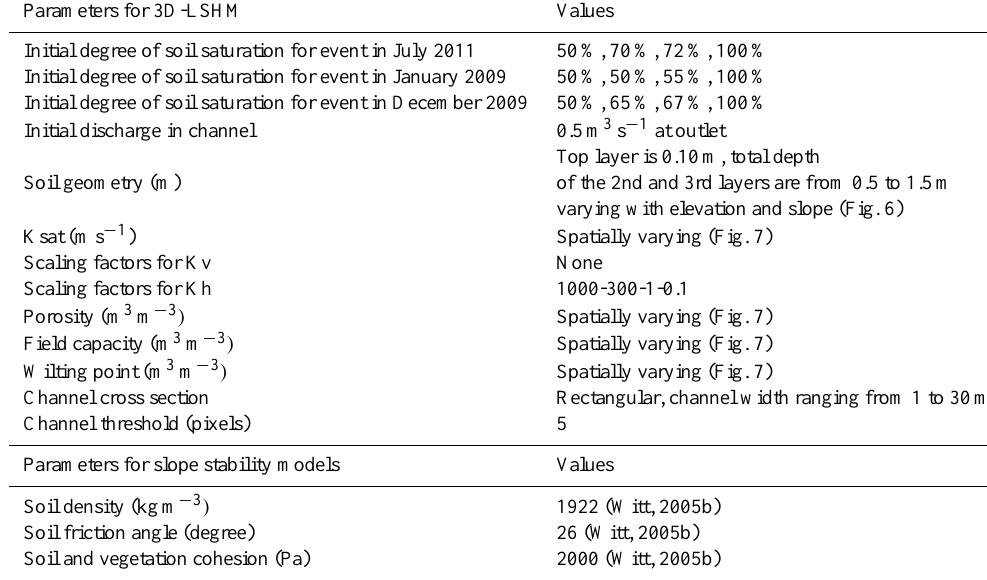
Table 1. Major parameters specified in LSHM for the three